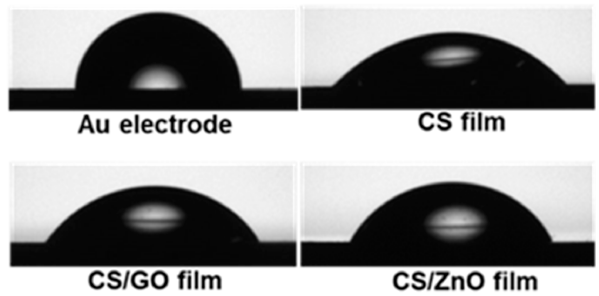
Figure 4. Contact angle measurements on Au electrode, CS, CS / GO, and CS / ZnO composite thin film cross-linked by GA.